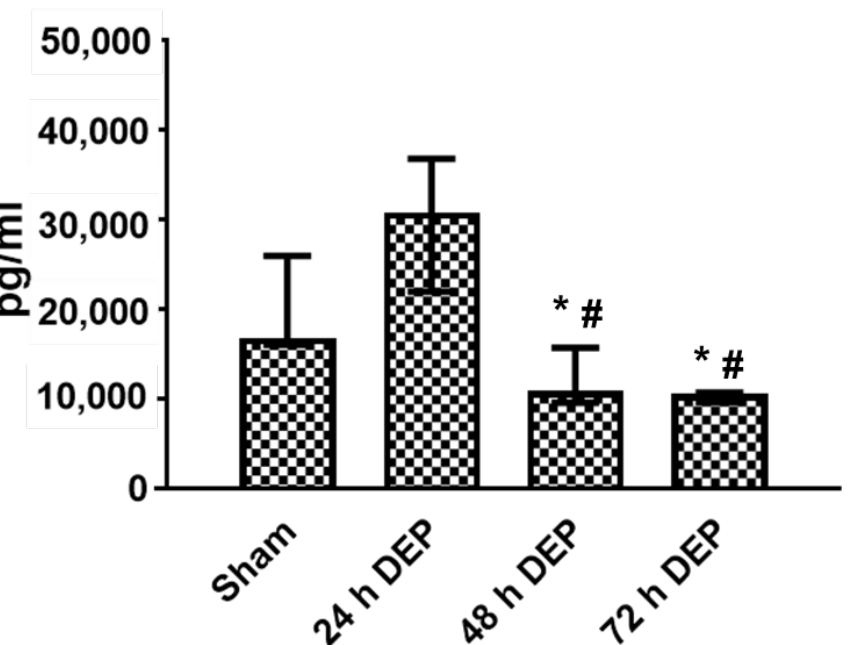
Figure 3. Release of IL8 in basal medium following repeated exposure to diesel exhaust particles (DEP: 12.7 µg/cm 2 ). Concentration of IL8 in bronchial mucosa models developed at the air-liquid interface (bro-ALI) following incubation for 24 hours (h) after 3 min exposure to sham (control: clean air exposure) and DEP for 3 time points (24, 48 and 72 h). Data presented as median and 25th – 75th percentiles (N = 3 donors and n = 2 replicates/donor). p < 0.05 *: significant compared to sham, #: significant compared to exposed at 24 h DEP.